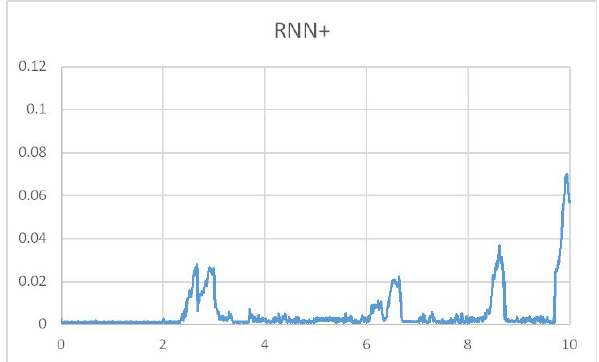
Figure 12. Delays on the path 2–11: RNN method.